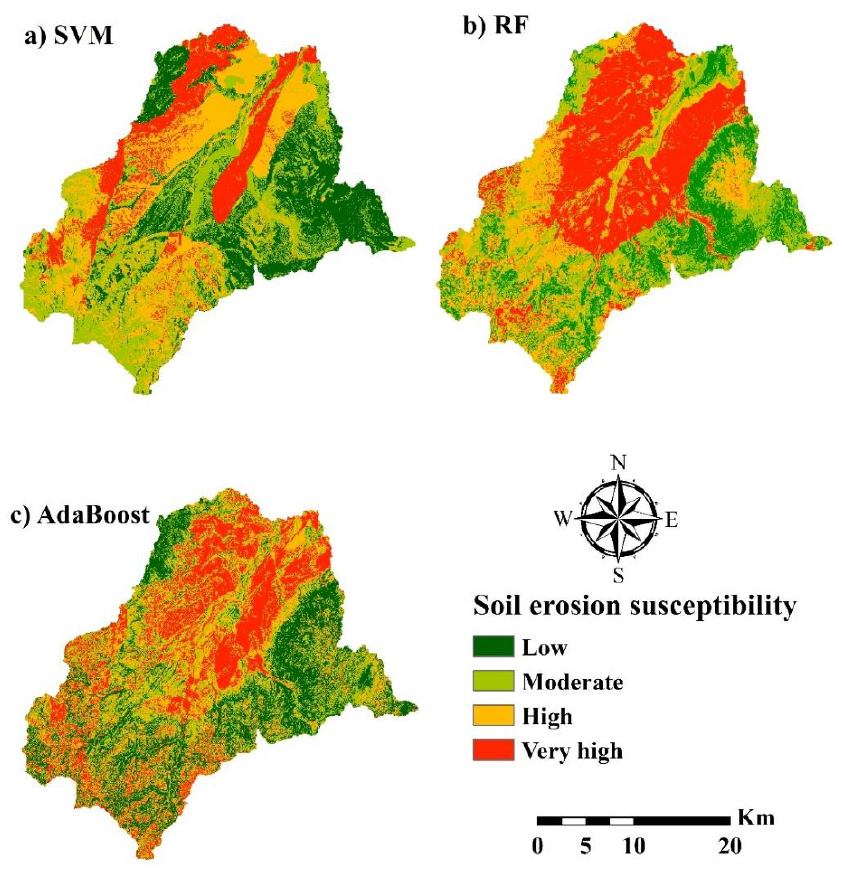
Figure 5. Surface erosion susceptibility modeling using: ( a ) SVM, ( b ) RF, ( c ) AdaBoost.